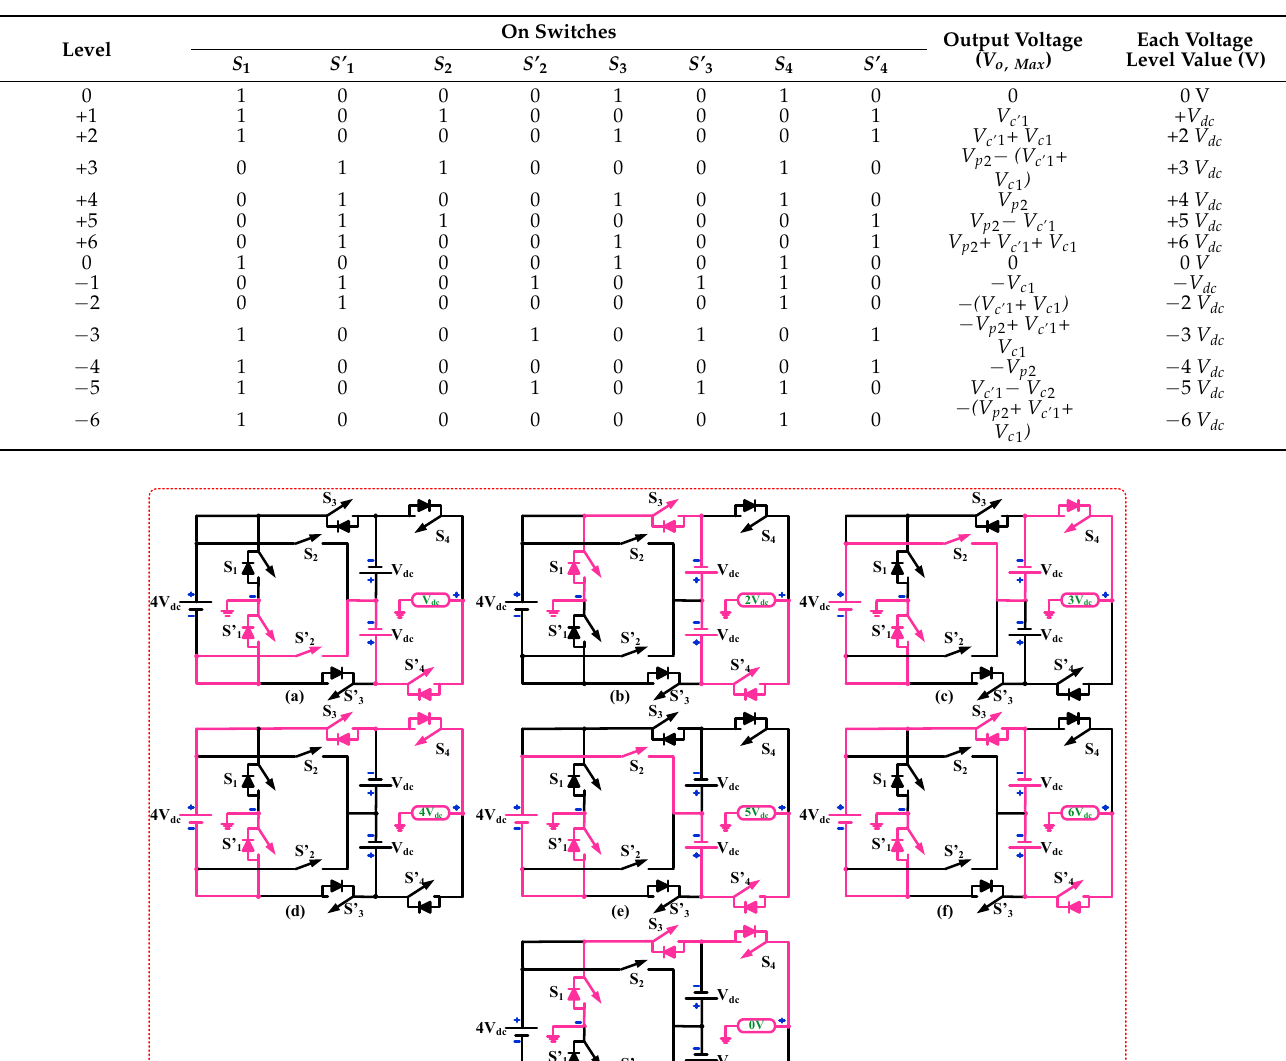
Table 1. Switching scheme for 13-level generation.